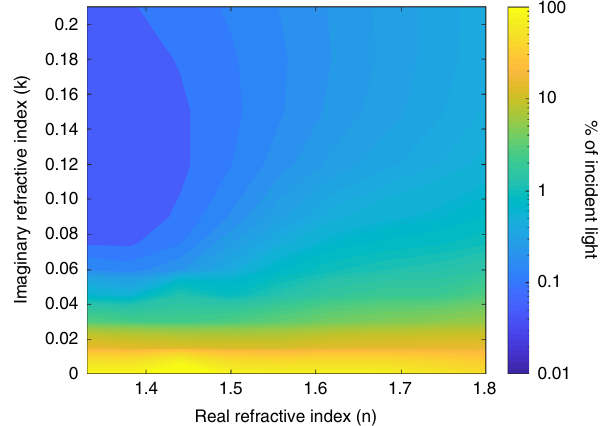
Fig. 5 Re fl ectance is primarily driven by the imaginary part of the refractive index. Contour plot of the simulated re fl ectance at 550 nm from scales with 99 unique combinations of real and imaginary parts of the refractive index. Re fl ectance is considered to be the re fl ectance from two overlapping scales backed by a 100% re fl ecting white surface. Real part of the refractive index varies from water ( n = 1.33) to melanin ( n = 1.8), and the imaginary part varies from k = 0.0 (no absorption) to k = 0.20. Color indicates re fl